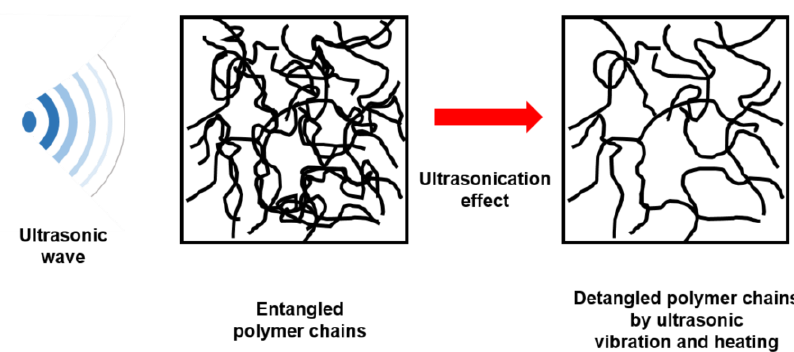
Figure 4. Variation in polymer chains due to ultrasonication.